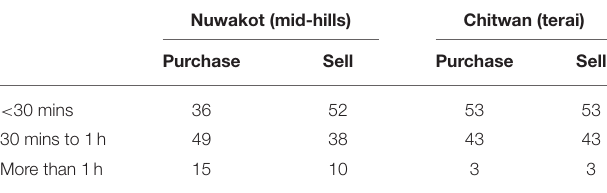
TABLE 7 | Average access time to markets in study areas, Nepal. Nuwakot